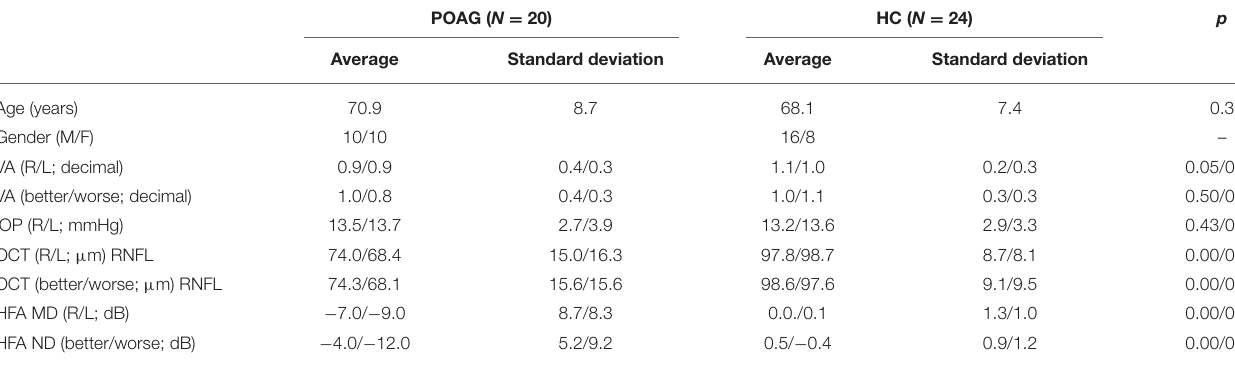
TABLE 1 | Demographic and clinical information of